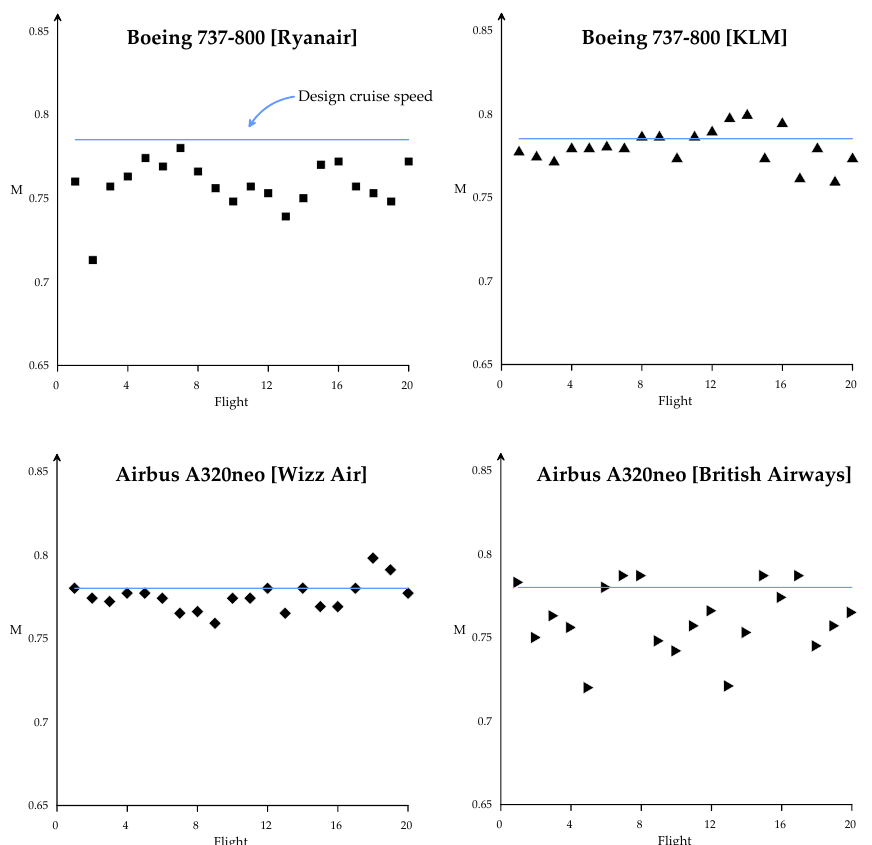
Figure 7. Cruise flight speed from a total of 80 analyzed flights. Boeing 737-800 by Ryanair and KLM. Airbus A320neo by Wizz Air and British Airways. Data sourced from Flightradar24